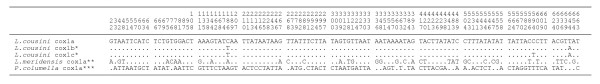
Nucleotide differences found in the mtDNA cox1 sequence of the lymnaeid species studied. Position = numbers (to be read in vertical) refer to variable positions obtained in the alignment made with MEGA 4.0. Identical = .; Indel = -. Haplotype codes only provisional due to incomplete sequences of the gene. Sequence correspondences: * L. cousini cox1b and cox1c correspond to two different haplotypes found in L. bogotensis; ** L. meridensis n. sp. = L. cousini from Laguna Mucubaji (Venezuela); *** P. columella cox1a from Puerto Rico = L. ubaquensis cox1a